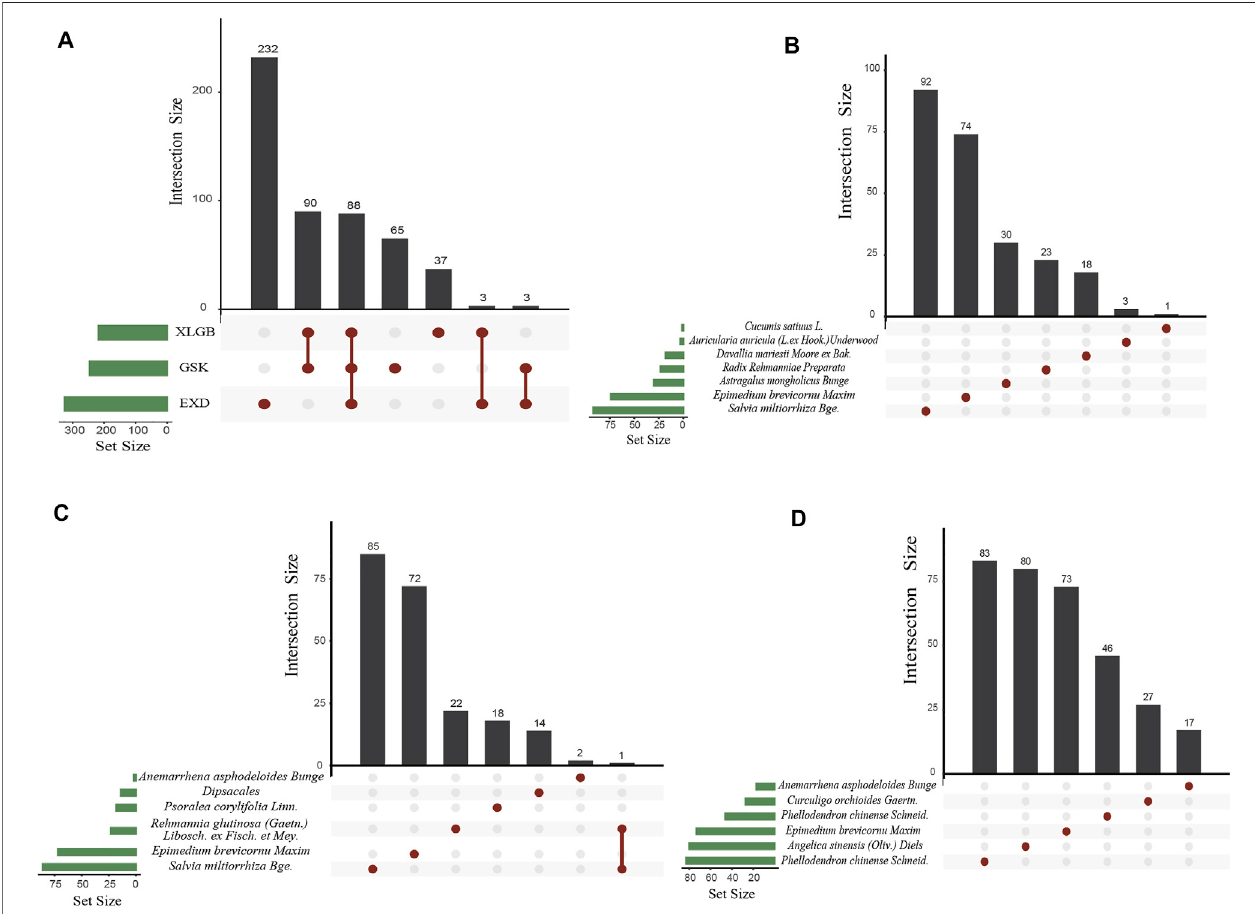
FIGURE2| DistributionmapofactivecomponentsinGSK,XLGB,andEXD (A) .CommoncomponentsofGSK,XLGB,andEXD (B – D) .Distributionmapofherbsin GSK (B) . XLGB (C) . and EXD (D) .